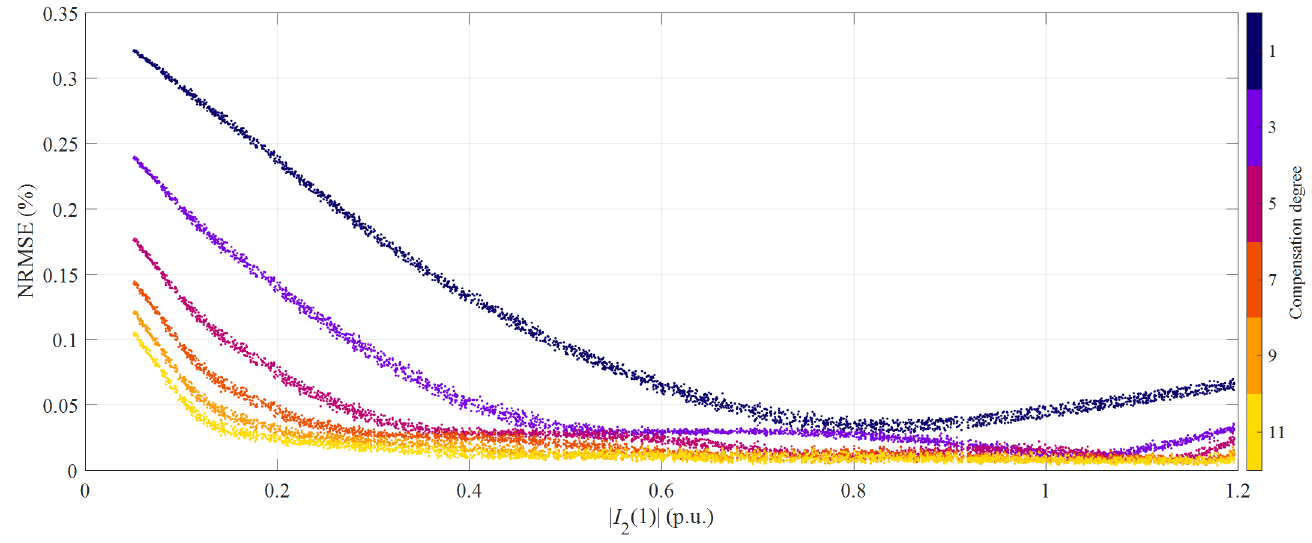
Figure 2. NRMSE as a function of the fundamental secondary current magnitude for different HD compensation degrees (numerical simulations).